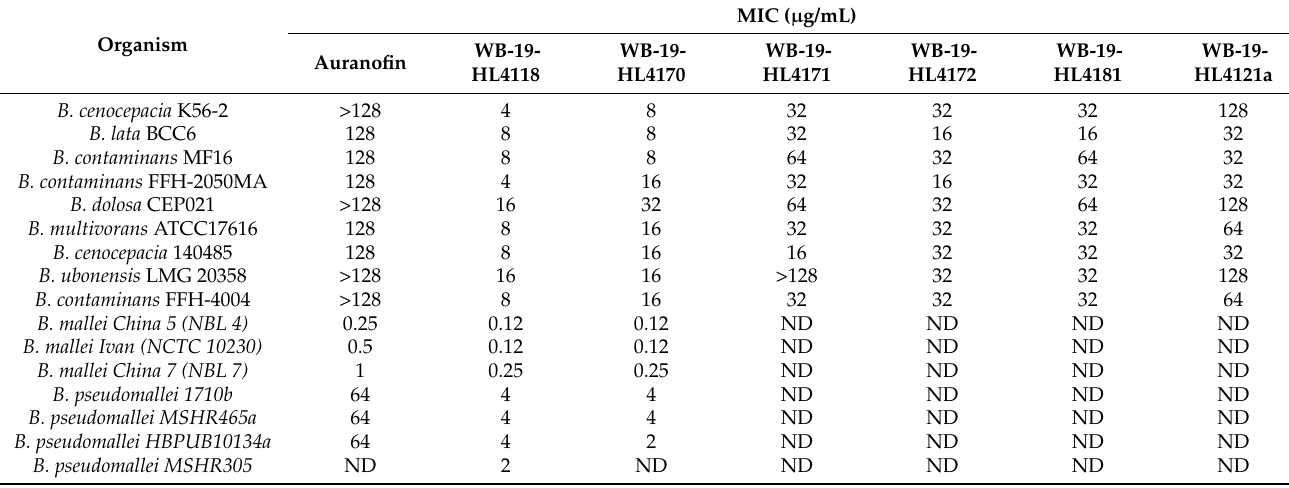
Table 1. Minimum inhibitory concentrations (MICs) of group two auranofin derivatives against Burkholderia cepacia com- plex (Bcc) bacteria, B. mallei and B. pseudomallei .